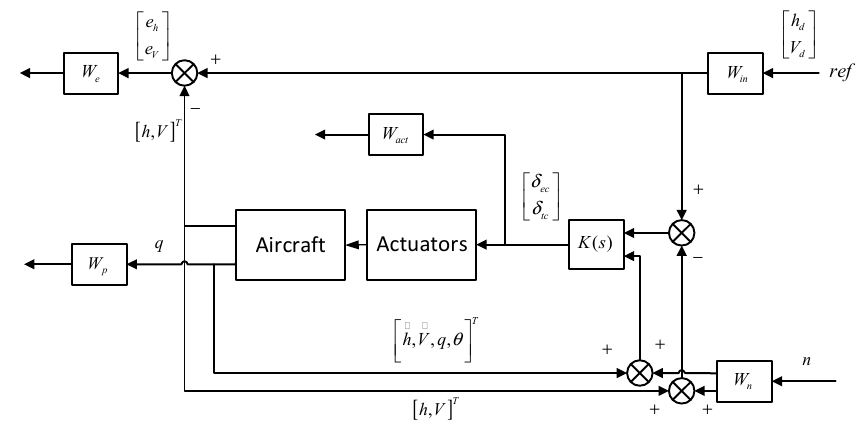
Figure 5. Interconnected structure of the general plant.